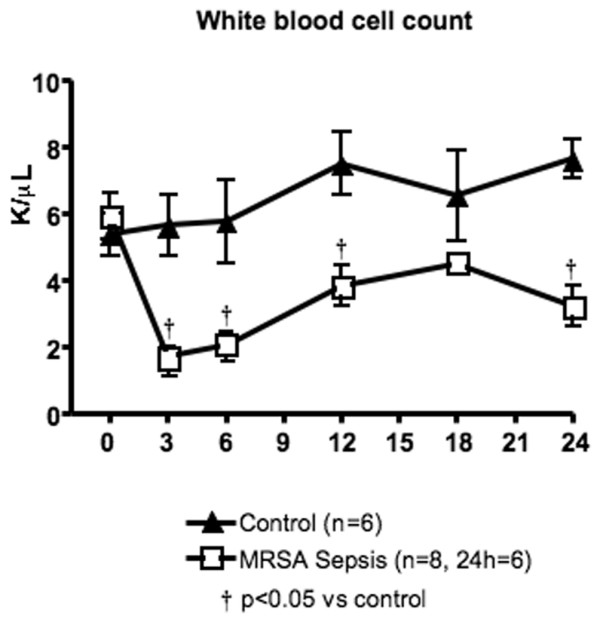
White blood cell count in control and methicillin-resistant Staphylococcus aureus (MRSA) sepsis groups. Data are expressed as mean ± standard error of the mean. † p < 0.05 versus control.